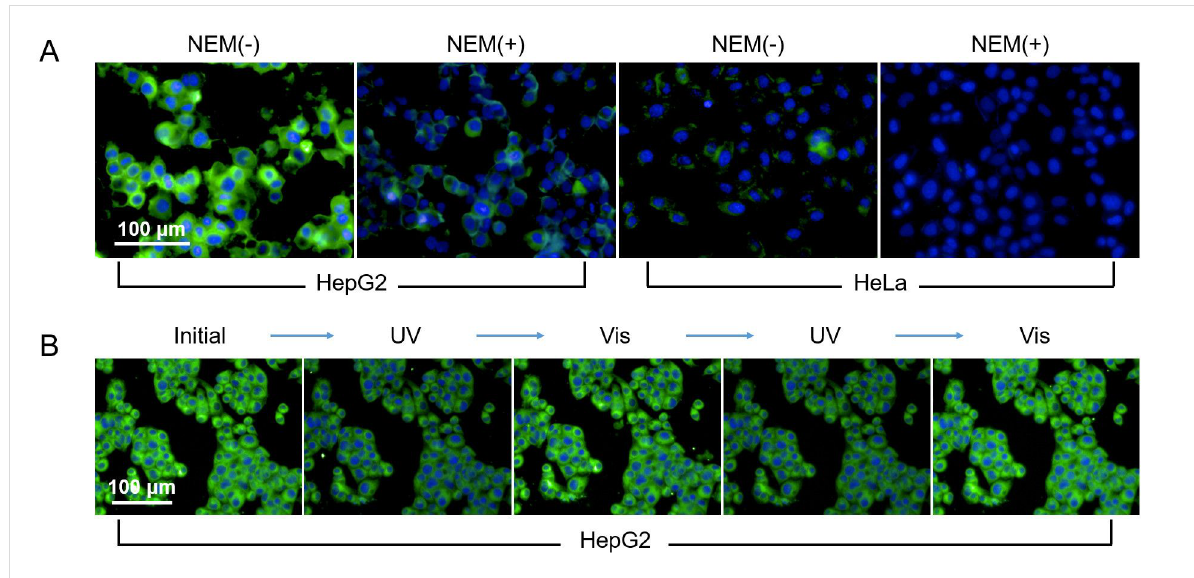
Figure 5: (A) Fluorescence imaging of HepG2 cells and HeLa cells after incubated with Glyco-DTE@MnO 2 photochromic glycosheet in the absence and presence of NEM. (B) The photochromic fluorescence imaging of HepG2 cells after incubated with glycosheet upon irradiation with UV (254 nm) and visible light (>500 nm). The excitation wavelength is 440 nm and the emission channel is 450–550 nm.